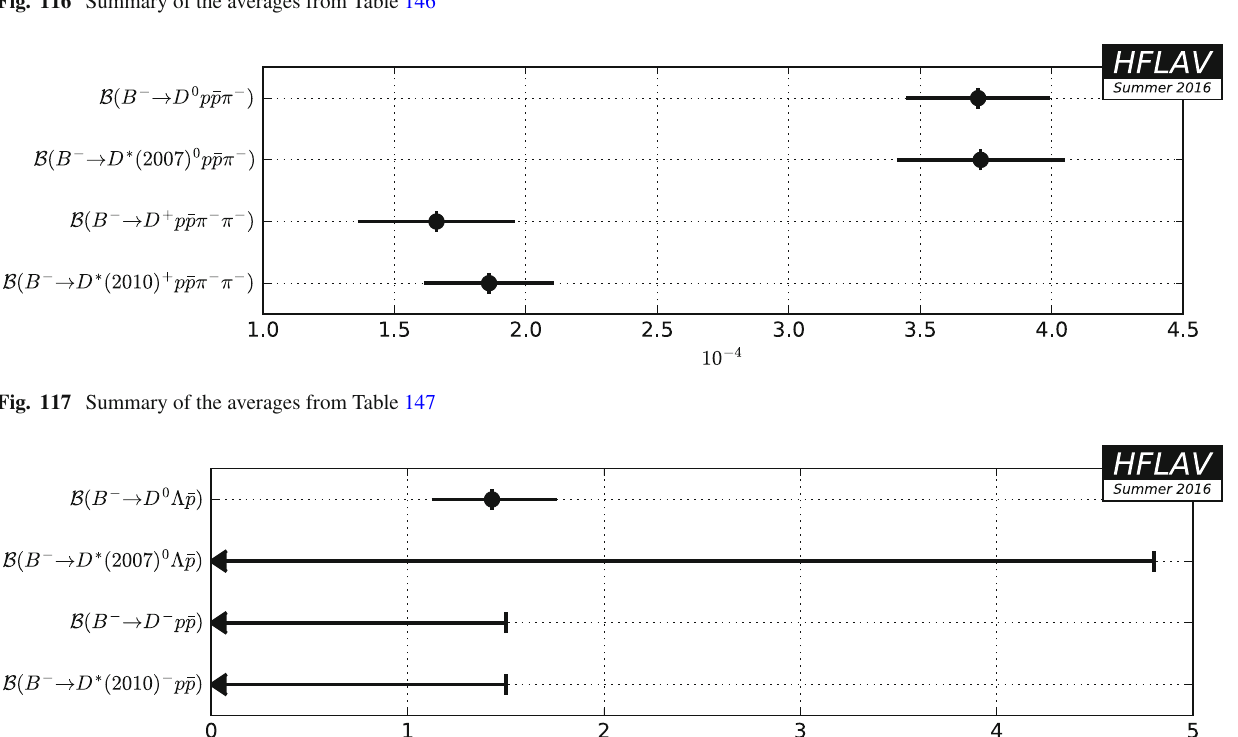
Fig. 116 Summary of the averages from Table 146